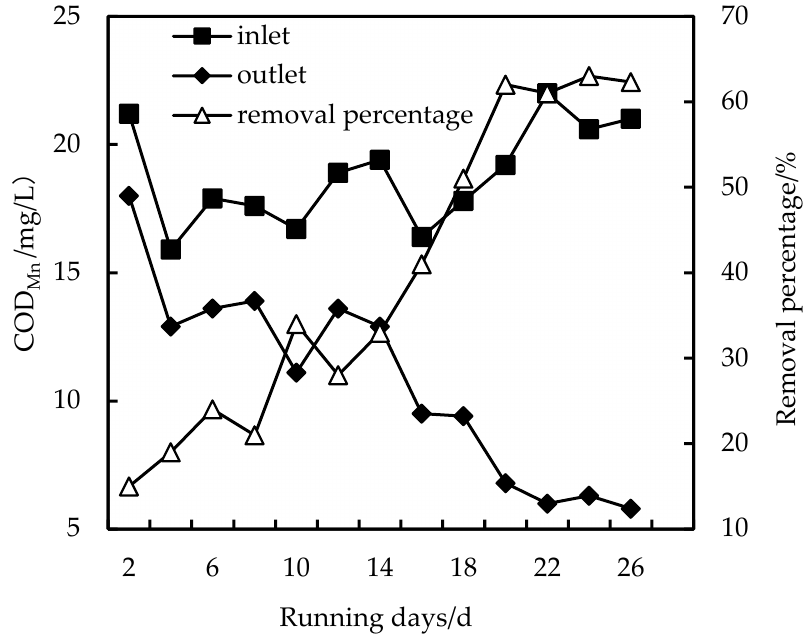
Figure 4. Removal of COD Mn with PAC-HUM.